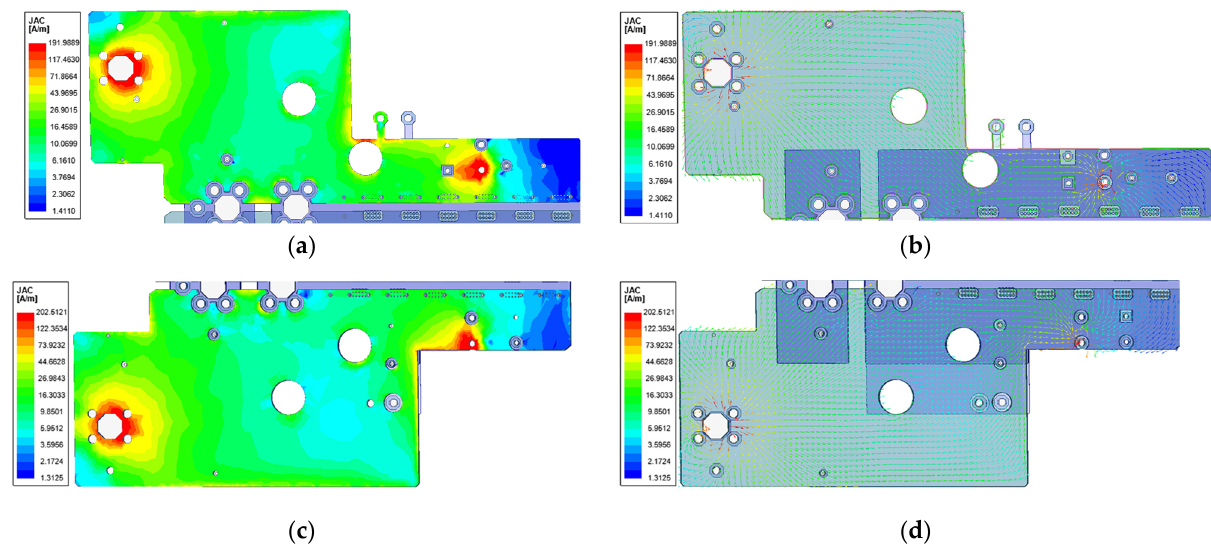
Figure 11. Q3D simulation results at bottom layer. ( a ) Current density of high side. ( b ) Current flow of high side. ( c ) Current density of low side. ( d ) Current flow of low